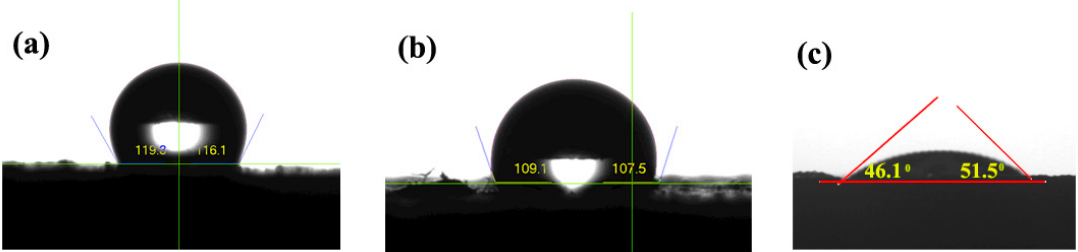
Figure 10. Water contact angle measurement of sample S4 at time of exposure of ( a ) t = 0 h ( b ) t = 1 h and ( c ) t = 5 h.